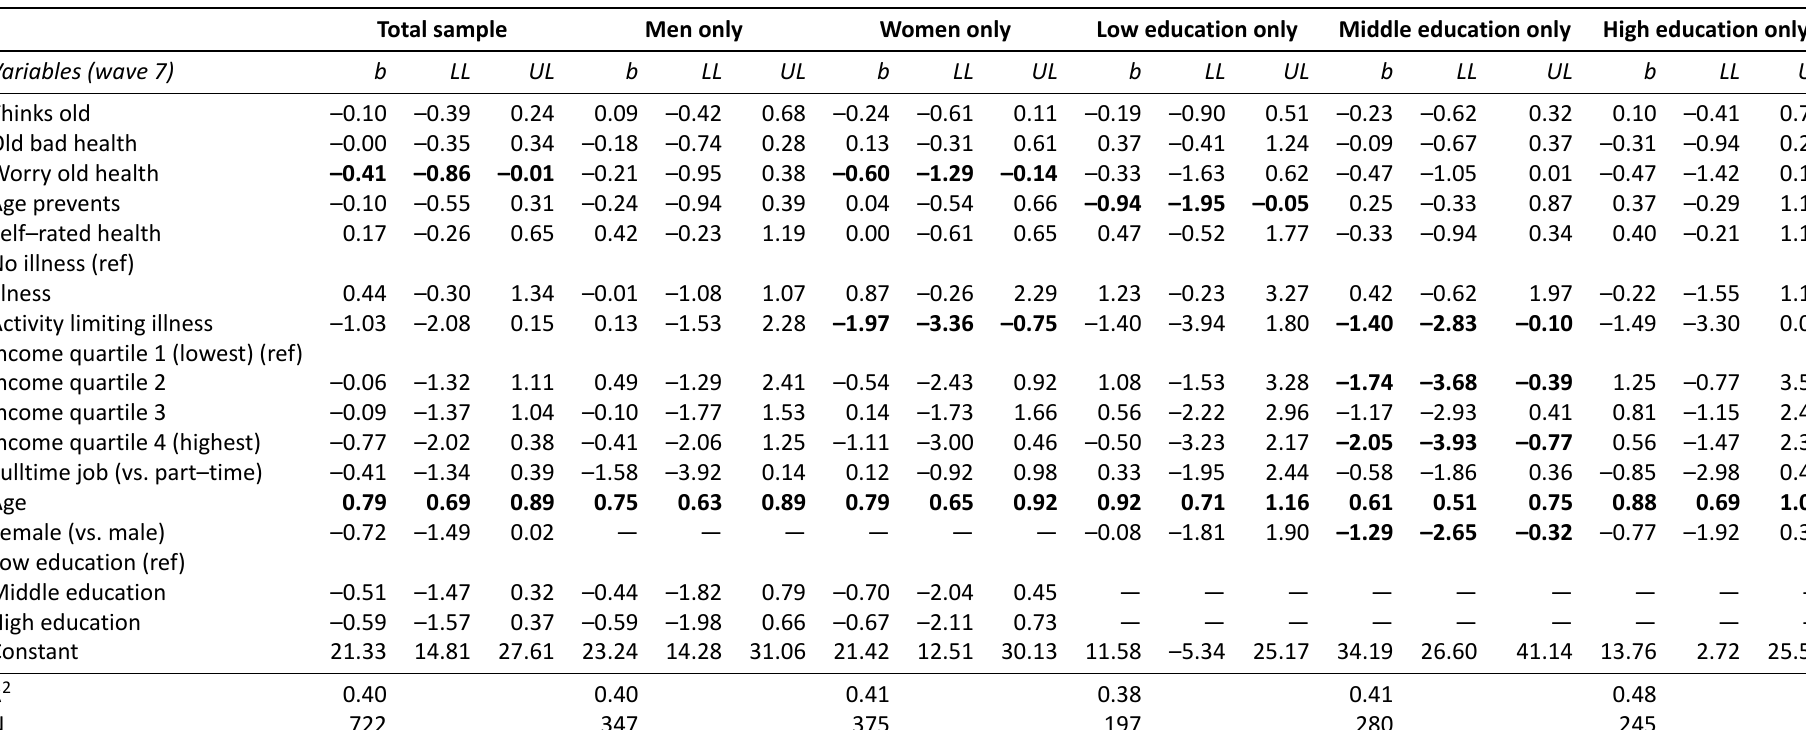
Table 3. Regression preferred retirement age wave 8, with